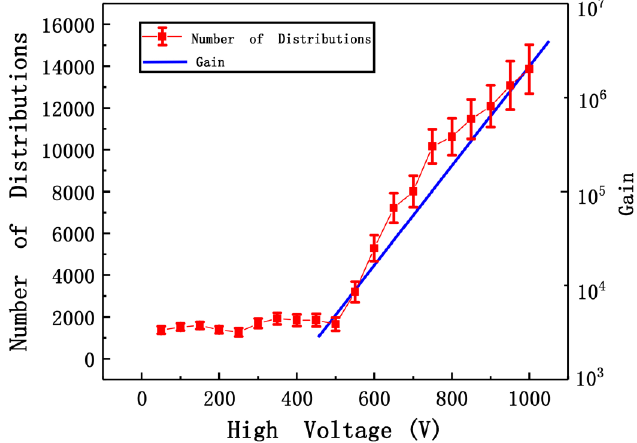
Figure 9. Spatial variance of the photon-counting data with different high voltages of the PMT settings in clear atmospheric conditions. ( a ) High voltage of 900 V; ( b ) high voltage of 600 V.